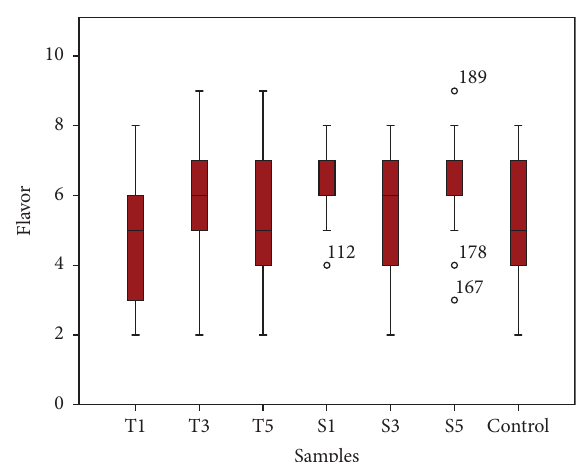
Figure 5: Box-plots obtained for the favour of prepared cake samples.